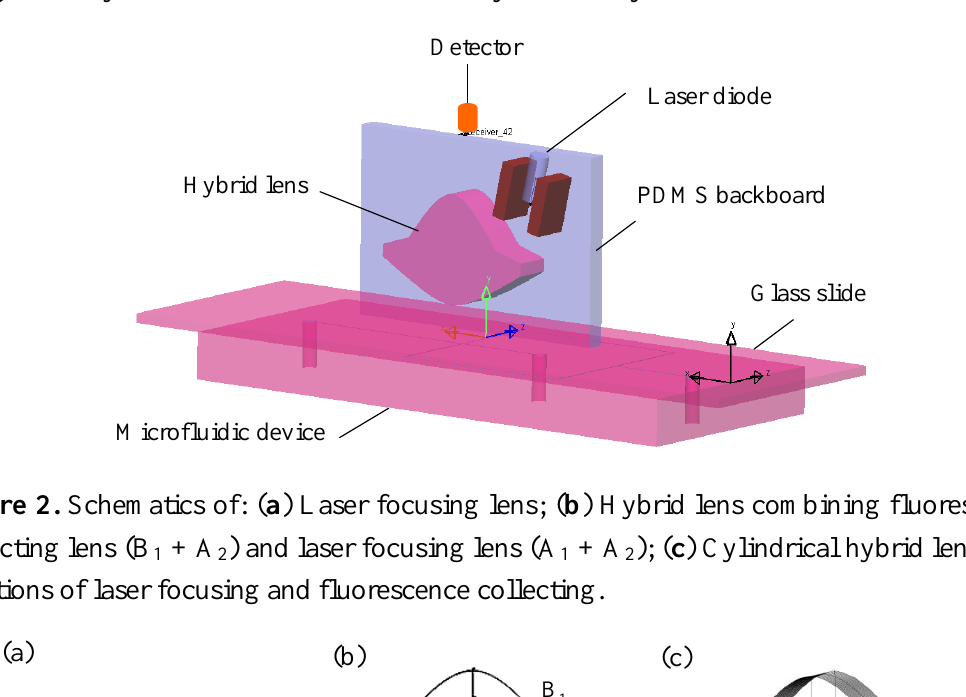
Figure 1. System scheme of PDMS-based cylindrical hybrid lens used in microfluidics.